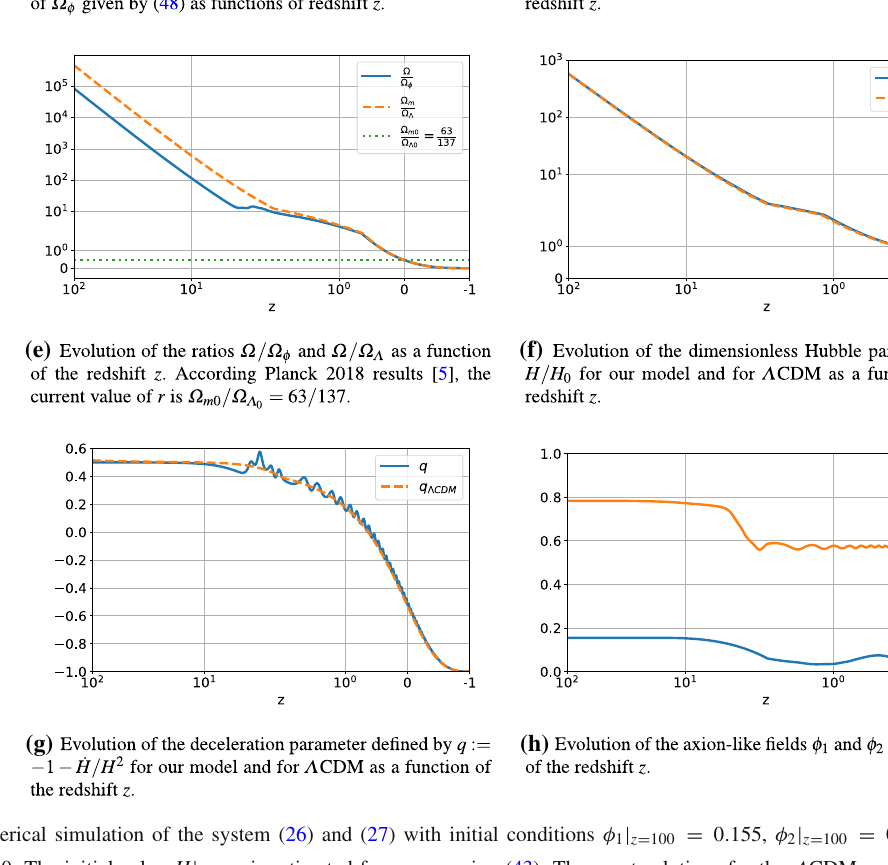
Fig. 1 Numerical simulation of the system (26) and (27) with initial conditions φ 1 | z = 100 = 0 . 155, φ 2 | z = 100 = 0 . 7835, d φ 1 d φ 2 = 0. The initial value H | dz z = 100